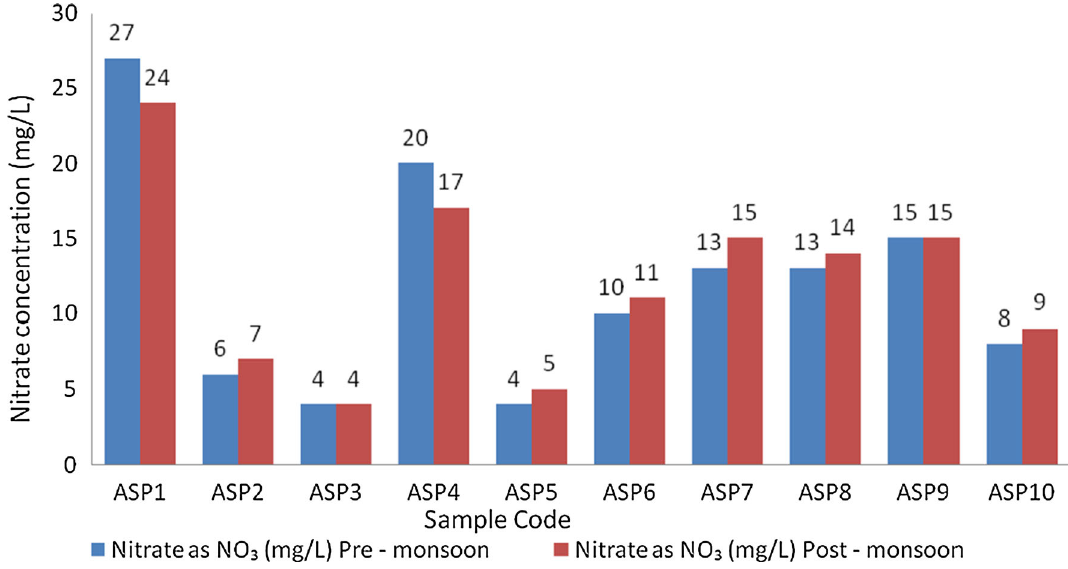
Fig. 15 Nitrate concentration in samples BIS limit (45 mg/L) collected from Laxmi